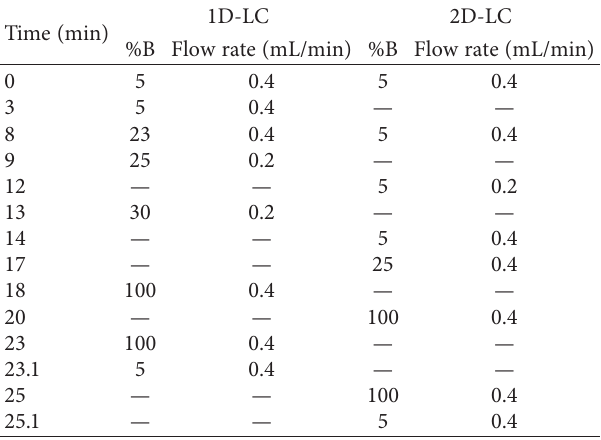
Table 1: 1D-LC and 2D-LC gradient for methomyl analysis. 1D-LC Time (min)